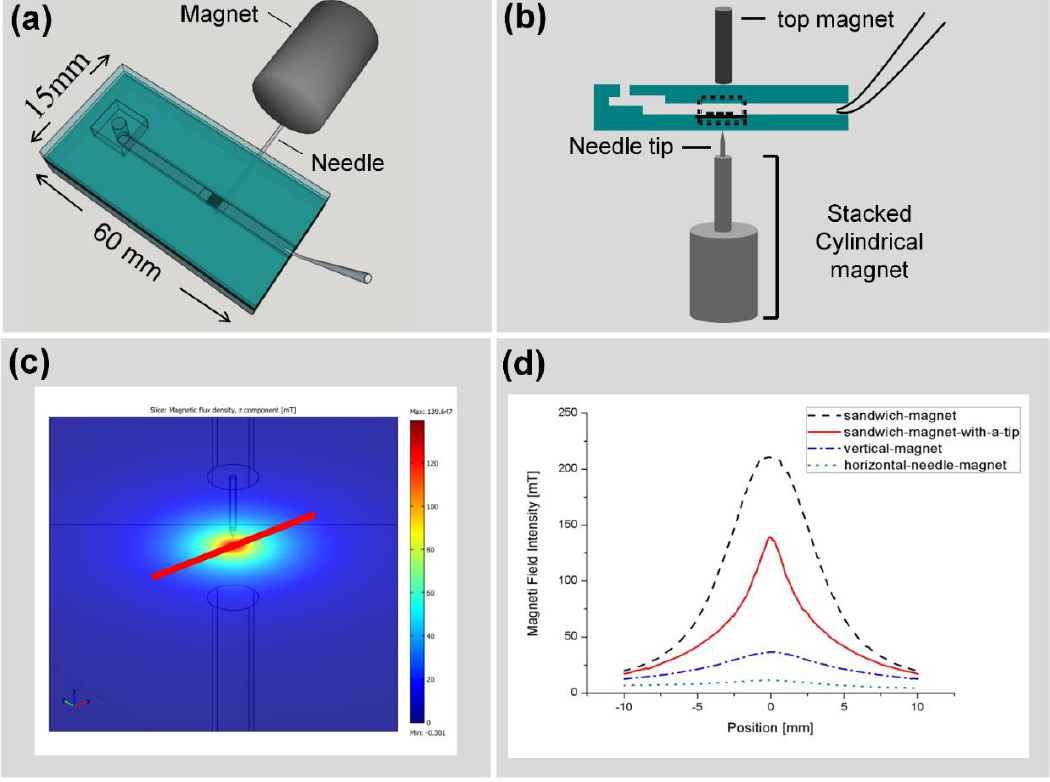
Figure 5. ( a ) Integration of magnet with funnel chip with a cylindrical neodymium magnet attached to a needle placed horizontally beneath the funnel chip (horizontal-needle-magnet). ( b ) Integration of funnel chip with stacked cylindrical magnet with different arrangements of a needle tip and another magnet on the top. The local magnetic field for a number of configurations was simulated with a Finite Element Package (COMSOL ® 3.5). ( c ) Geometric model of the Nickel-coated needle and Neodymium magnets. The 2D magnetic field intensity distribution in the plane of the nanoslit is shown. ( d ) Magnetic field distribution for the needle and magnet configuration in the various configurations of horizontal-needle-magnet (dotted line), vertical-magnet (dashed-dotted line), sandwich-magnet (dashed line) and sandwich-magnet-with-a-tip (solid line) are